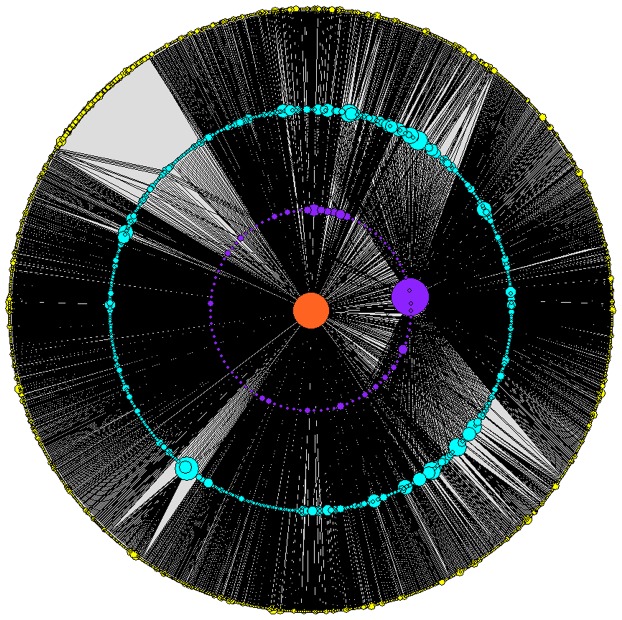
The core structure of the MSM exclusive network.
The numbers of individuals in the different cores were: 1-core: 3261; 2-core: 1302; 3-core: 564 and 4-core: 249. Each node in the graph represents an interconnected sub-cluster of nodes with similar core number. The sizes of the nodes represent the logarithmic size of the clusters.